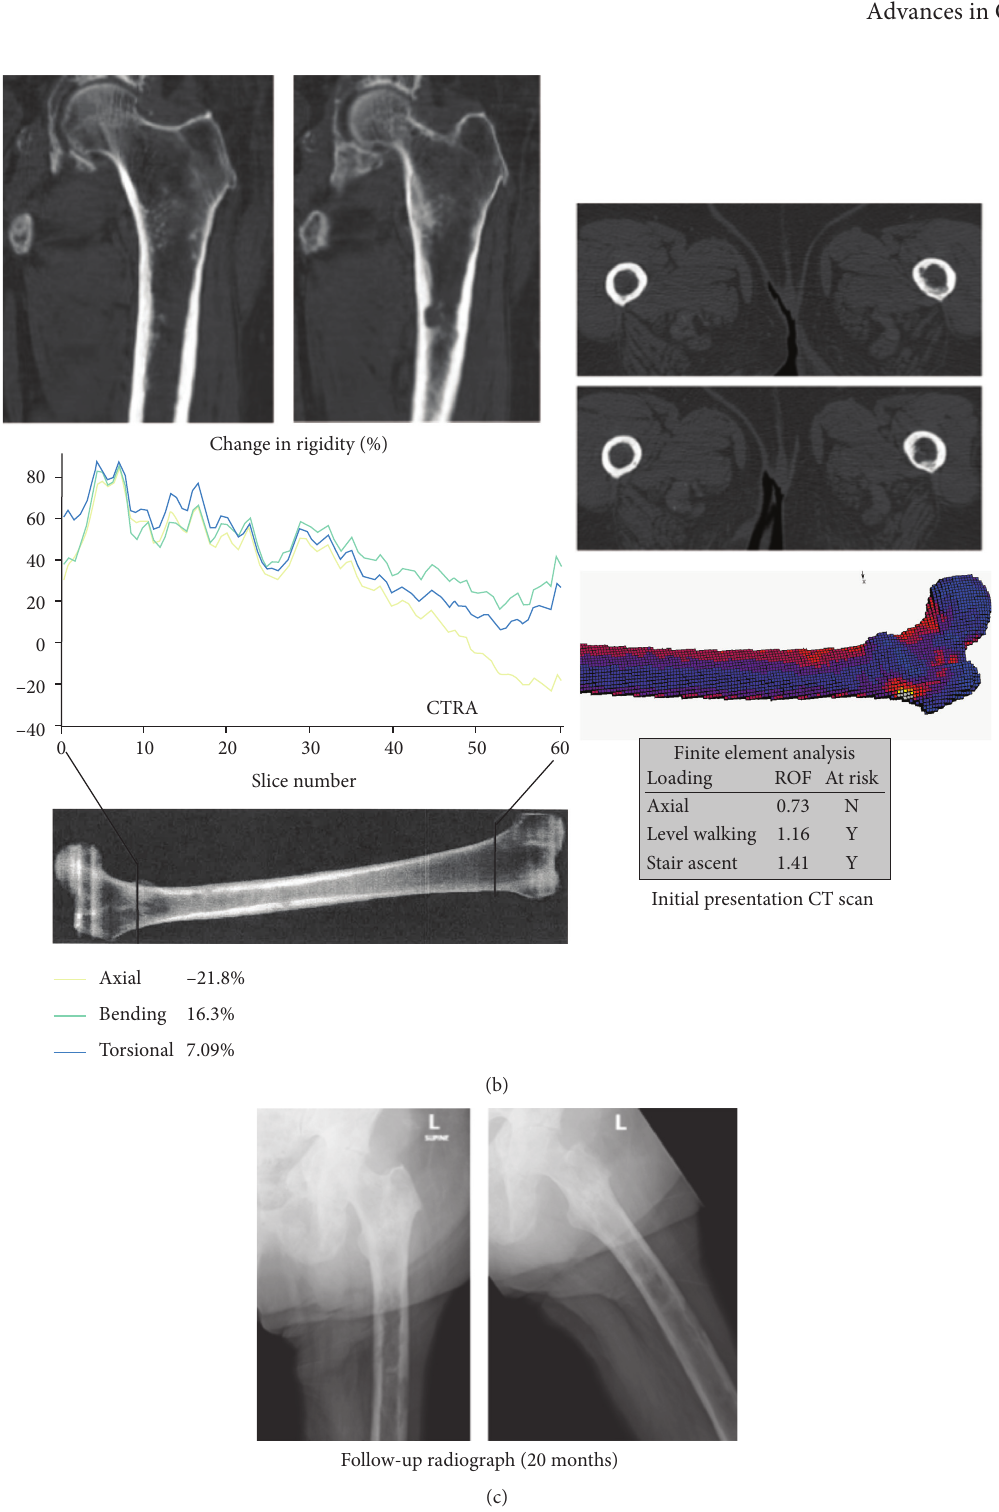
Figure 8: True negative (CTRA-/Fx-) (Case 7, L femur). (a) This is a 72-year-old female with breast cancer and extensive MBD showing a mixed osteoblastic and osteolytic lesion in the left femoral diaphysis. (b) While CTRA predicted that the subject would not fracture, FEA did predict fracture. (c) She was followed for two years without evidence of fracture. Imaging taken at 20 months demonstrates MBD without a